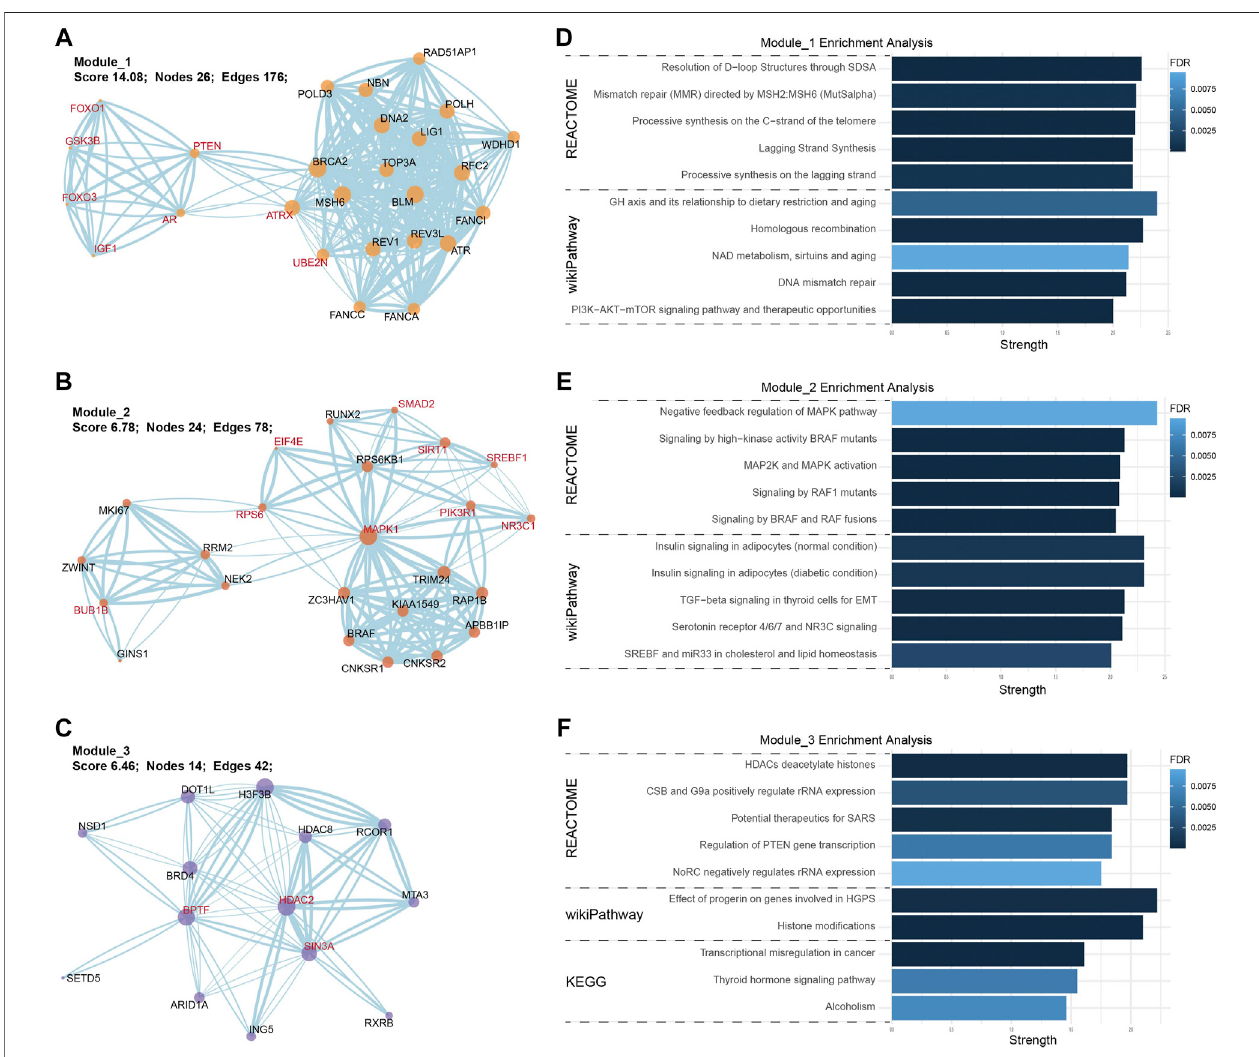
FIGURE6| PPInetworkandenrichmentanalysisofhsa-miR-486-5ptargetedtranscripts.Thetop3corePPImoduleswerebuiltbyMCODEplugin. (A) Module_1 consisted of 26 nodes and 176 edges; (B) Module_2 consisted of 24 nodes and 78 edges; (C) Module_3 consisted of 14 nodes and 42 edges (hub genes were highlighted in red). In enrichment analysis, module_1 was enriched in DNA structure-related terms (D) , module_2 was enriched in MAPK signaling pathways (E), and module_3 was enriched in epigenetic terms (F) .